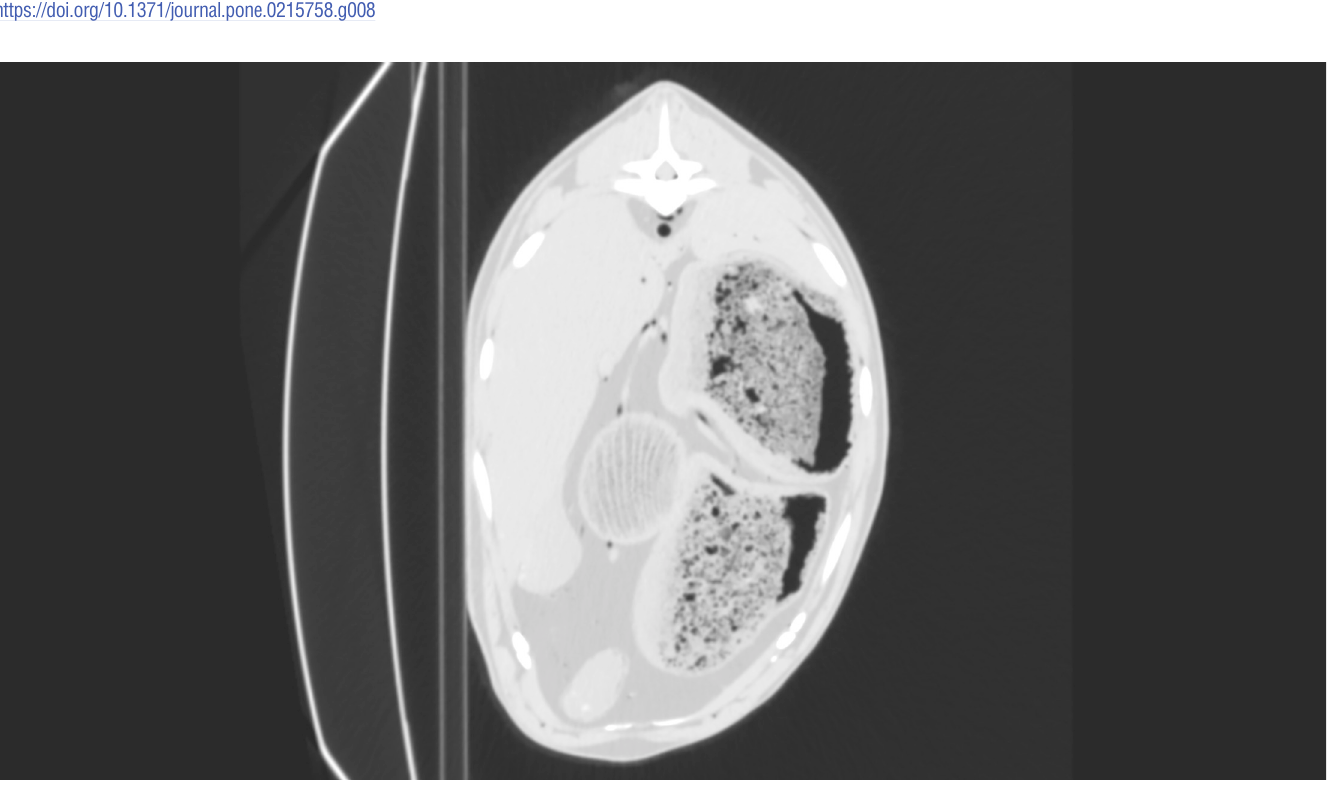
Fig 9. CT reconstruction in transverse plane at the level of the 12th thoracic vertebra after intra-arterial air inflation in volume 60ml/kg; lung window. Air-filled aorta is visible. Poorly air-filled liver and spleen veins. Complete lack of air-filling of the caudal vena cava and portal vein.